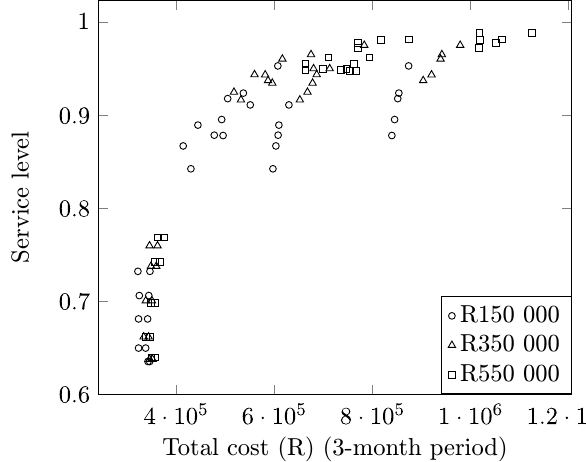
The overall effect of the reorder point value shows that a low reorder point limits the service level, whereas a high reorder point value increases the service level, but at high cost. When only one vehicle is used for cash distribution, a high reorder point value does not improve the service level because the vehicle cannot cope with the